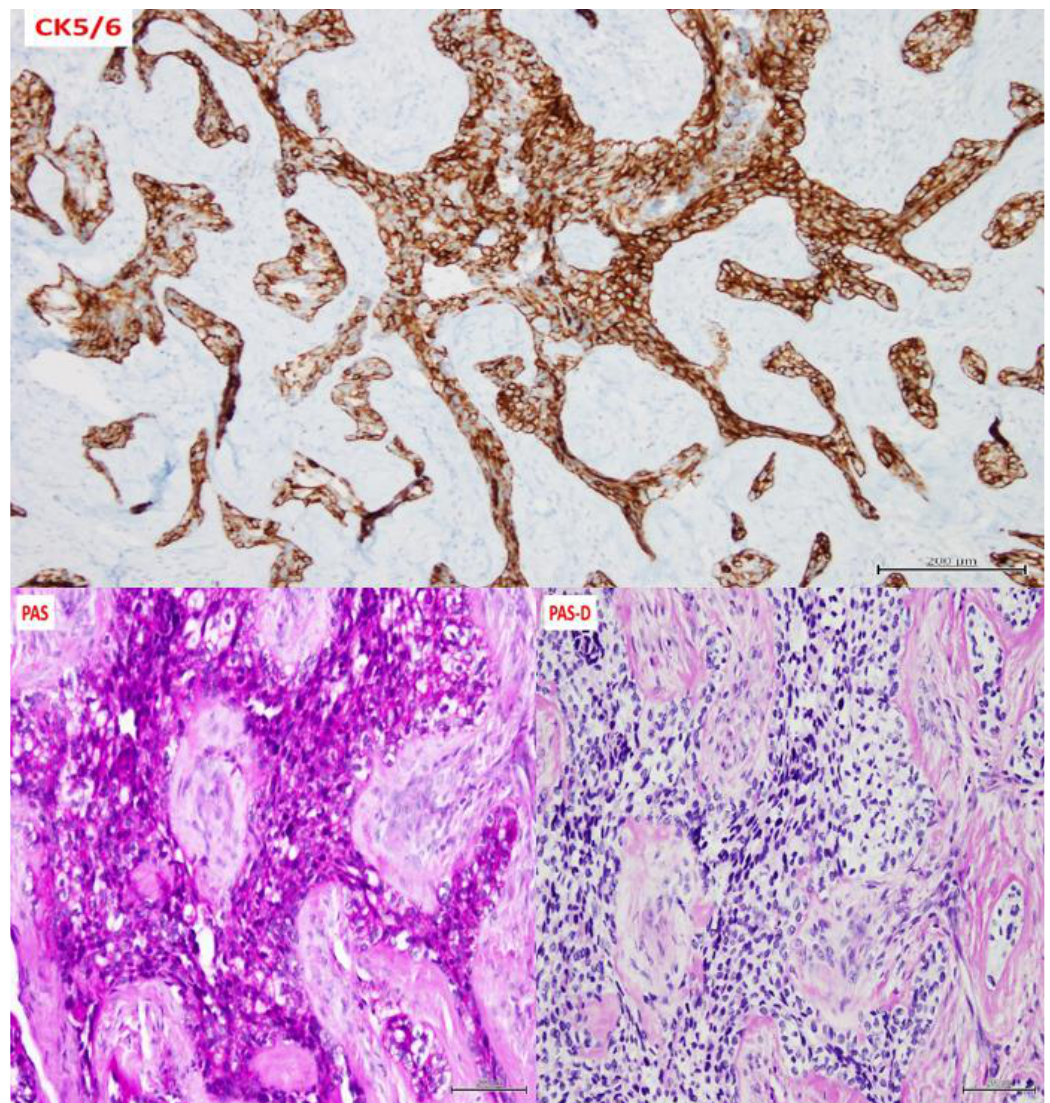
Figure 7. Case 2 immunohistochemistry was diffuse and strongly positive for CK5/6 and PAS- stain which was diastase-labile (200×).